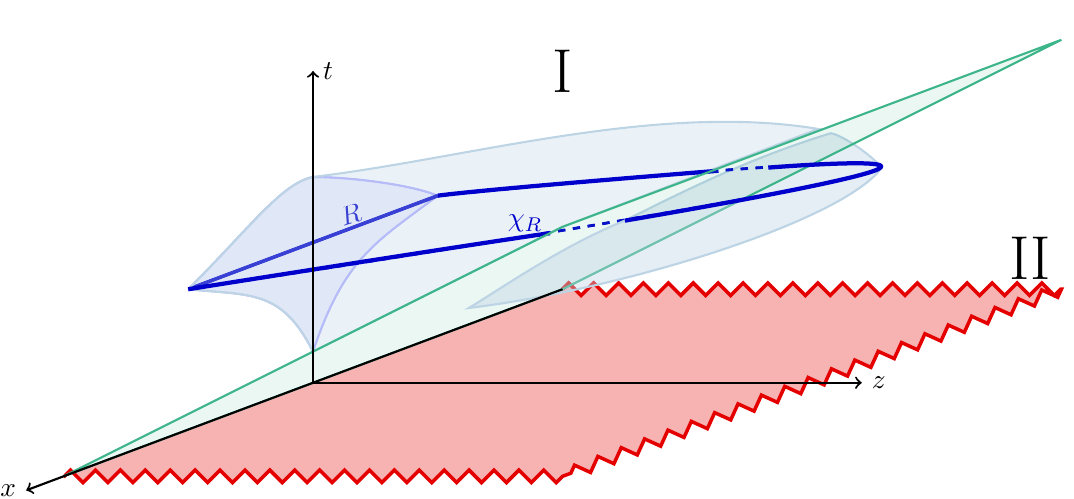
Figure 7 . The entanglement wedge EW region R in the contracting branch ( p < 0) probes region II. Its boundary causal domain D complete, and so is the entanglement wedge EW